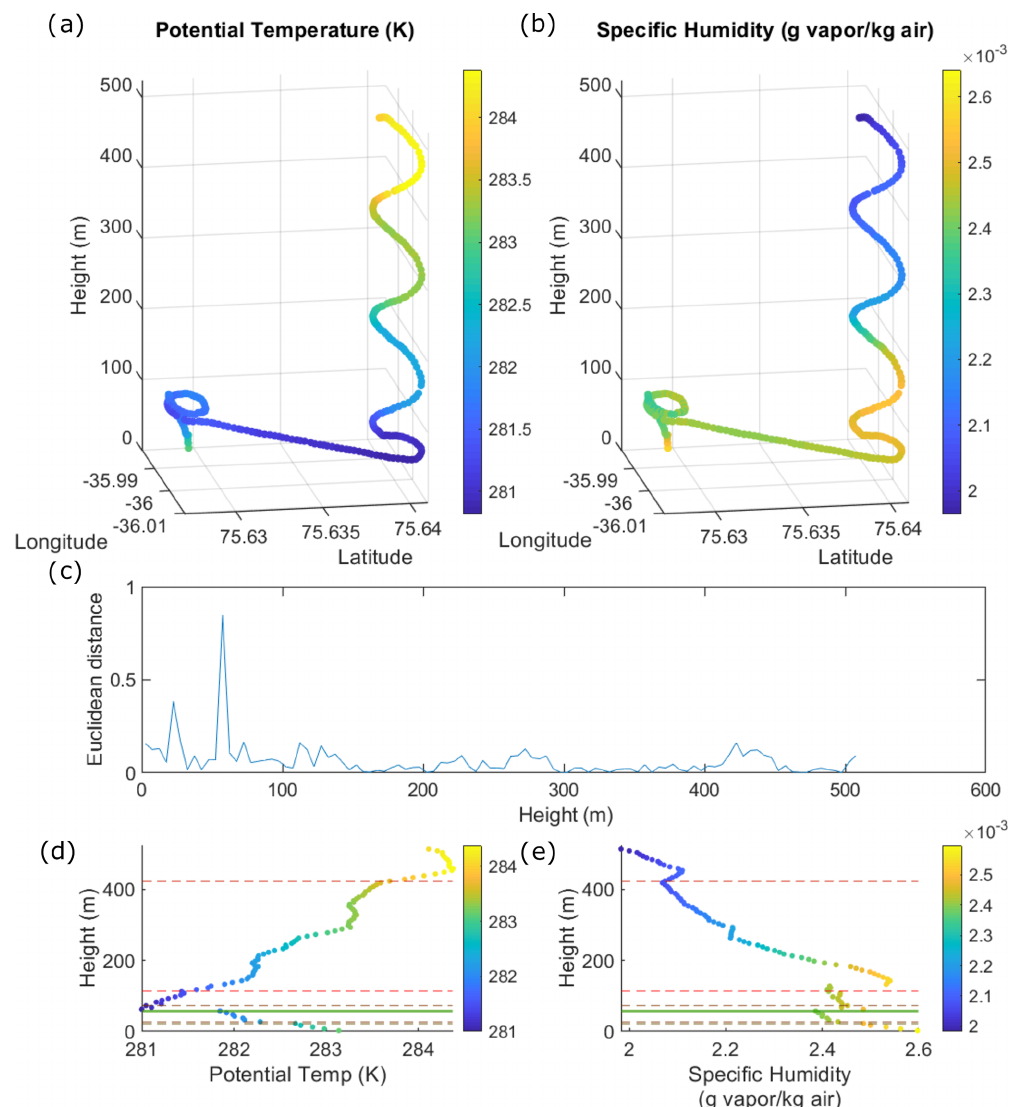
Figure 9. The ascension profile for the 21 June flight mission available to the operator to determine PBL location. The flight reached a maximum altitude of ∼ 500m ( a and b ). Post launch, the operator flew from the initial launch at ∼ 110 to ∼ 60ma . g . l . over the course of ∼ 1min. Settling of both temperature and humidity due to hysteresis during that time was flagged incorrectly by Euclidean distance (c) . The resulting predictions of PBL locations (solid green line for the most likely, dashed line for the next four likely, d, e ) are scattered across the